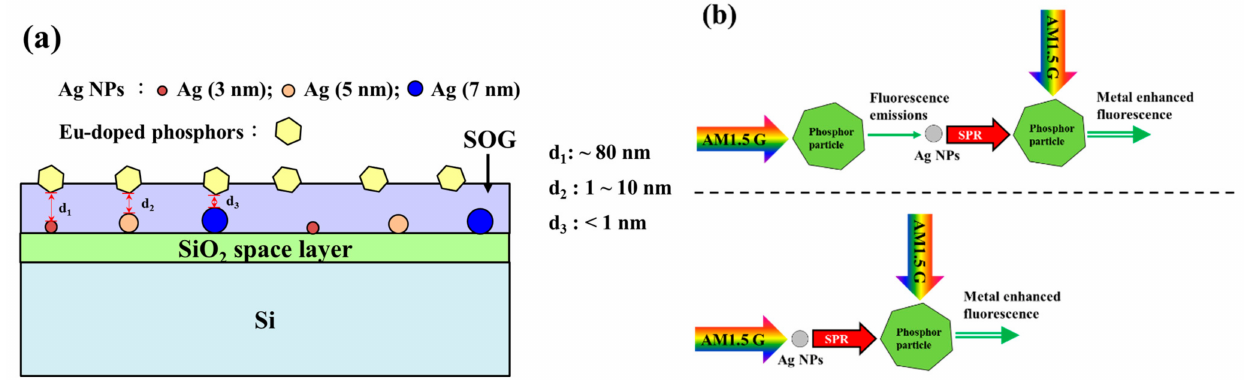
Figure 11. ( a ) Schematic diagram of Ag-NP and Eu-doped phosphor deposition on front surface of silicon substrate; ( b ) model of metal-enhanced fluorescence